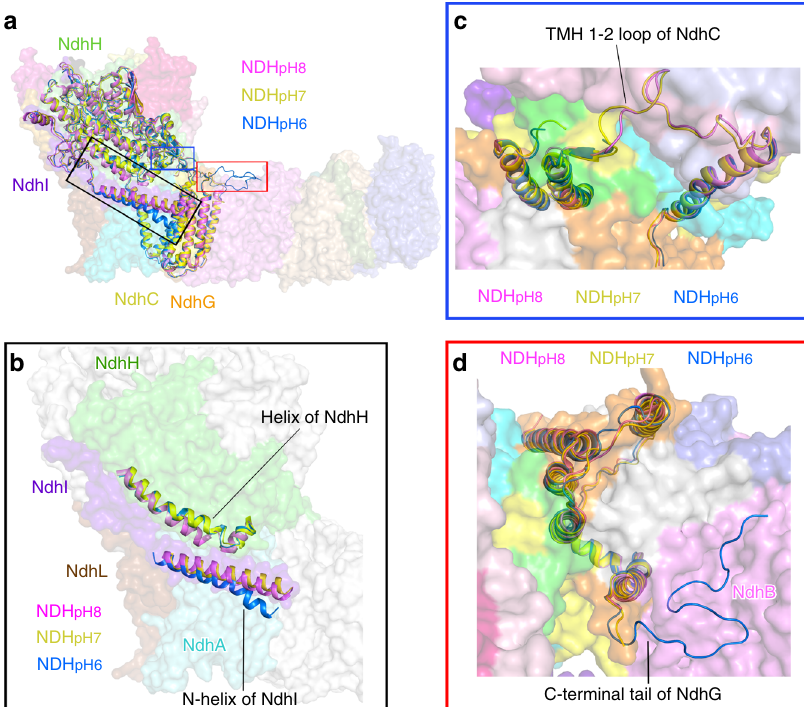
Fig. 6 Comparison of three NDH-1L structures under different pH conditions. a Comparison of NDH-PQ structure (NDH pH7 ) with previously reported two NDH-1L structures NDH pH6 and NDH pH8 (PDB codes: 6NBY and 6HUM) superposed on NdhA subunit. The subunits with structural differences are depicted as cartoons and labeled. The regions with evident differences among the three structures are circled with black, blue, and red boxes. b Comparison of the NdhI and NdhH subunits. The N-helix of NdhI and a helix of NdhH are highlighted as cartoons. The subunits similar in three NDH-1L structures are shown as surface mode (For clarity, only NDH pH7 structure is shown). c Comparison of NdhC subunits viewed from the stromal side. The TMH1-2 loop was not modeled in NDH pH6 structure. d Comparison of NdhG subunits viewed from the stromal side. Its C-terminal tail in NDH pH6 structure is almost completely modeled and interacts with the stromal region of NdhB. Color codes are the same as that in Fig.